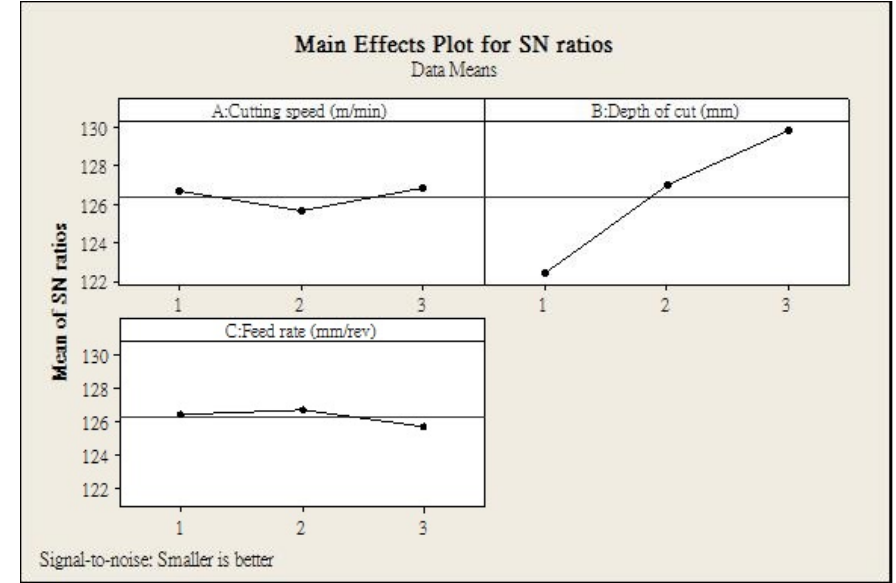
Figure 9. Main effects plot of the SNR (smaller-the-better).